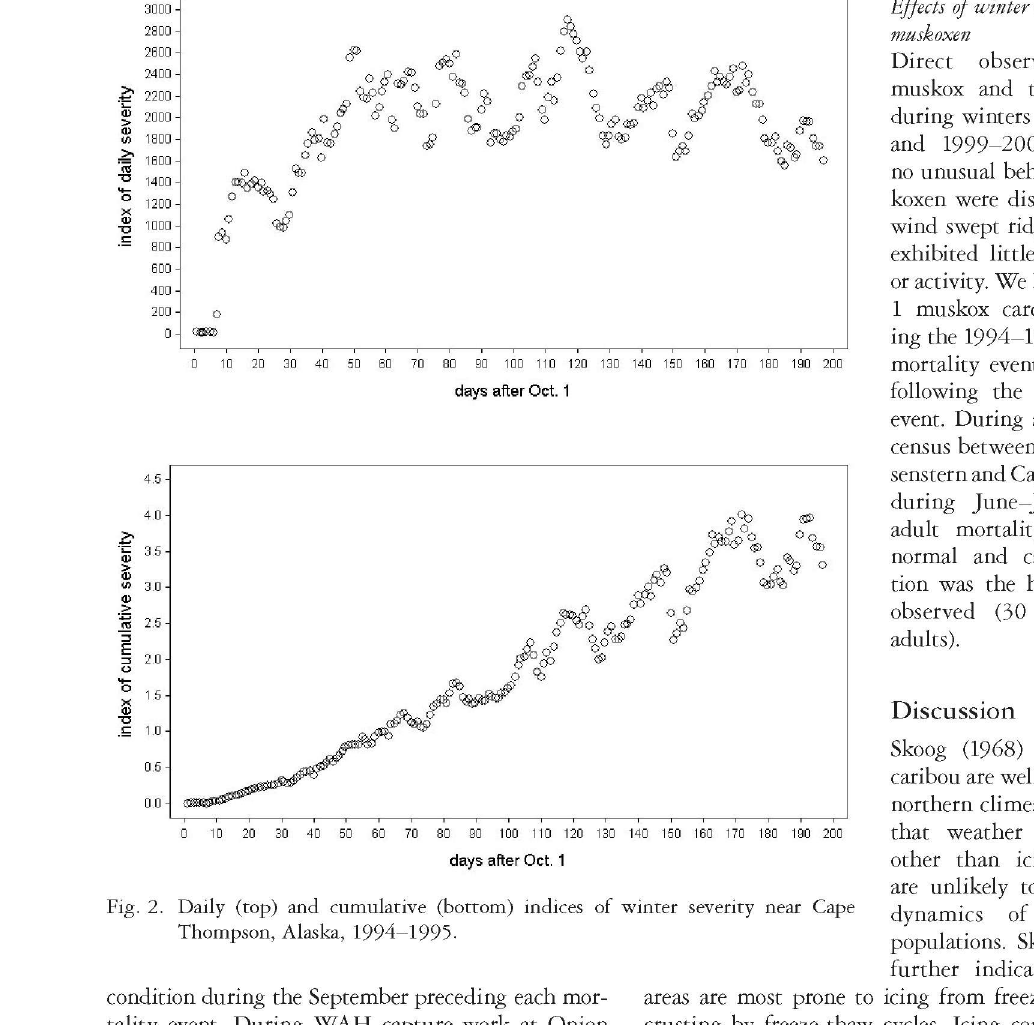
Fig. 2. Daily (top) and cumulative (bottom) indices of Thompson, Alaska,